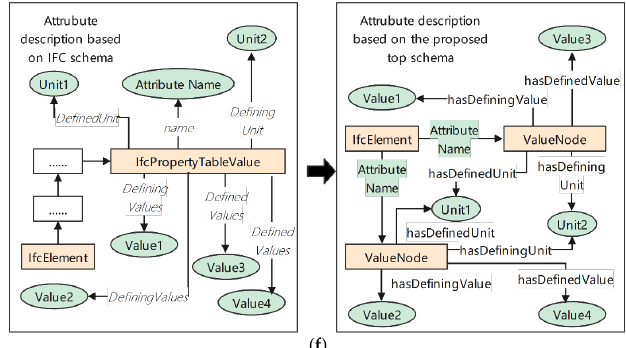
Figure 9. Reorganizations for different IFC properties based on the proposed top schema: ( a ) reor- ganization of “ IfcPropertySingleValue ” ; ( b ) reorganization of “ IfcPropertyBoundedValue ” ; ( c ) reor- ganization of “ IfcPropertyEnumeratedValue ” ; ( d ) reorganization of “ IfcPropertyListValue ” ; ( e ) re- organization of “ IfcPropertyReferenceValue ” ; ( f ) reorganization of “ IfcPropertyTableValue .” According to the IFC schema, these attribute names and related values are defined by “ IfcRelDefinesByProperties ” or “ IfcRelDefinesByType .” For example, the conversion of attributes defined by “ IfcPropertySingleValue ” via “ IfcRelDefinesByProperties ” can be realized by the attribute mapping rule, as illustrated in Figure 10a. If the attribute name is a predefined tag in the concept ontology and the related value is a Boolean “ True ,” the “ hasTag ” relationship will be created between the instances and the tag (see Figures 7 and 10b).